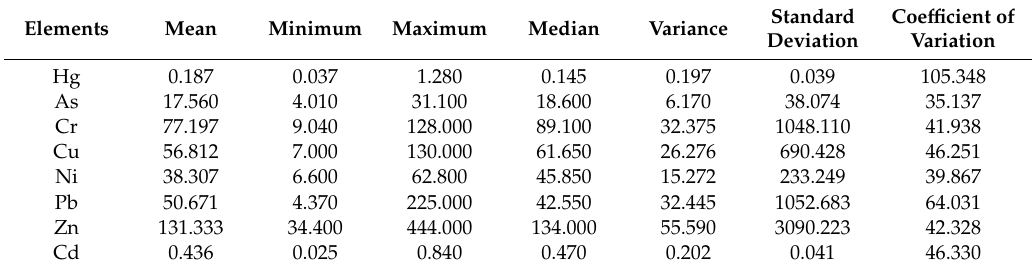
Table 4. Descriptive statistics of eight element concentrations in surface soils ( N = 60, unit mg / kg).